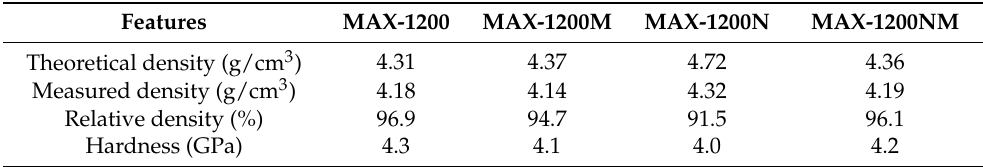
Table 2. Characteristics of the Ti 2 AlN MAX phase obtained in this work under the different SPS sintering